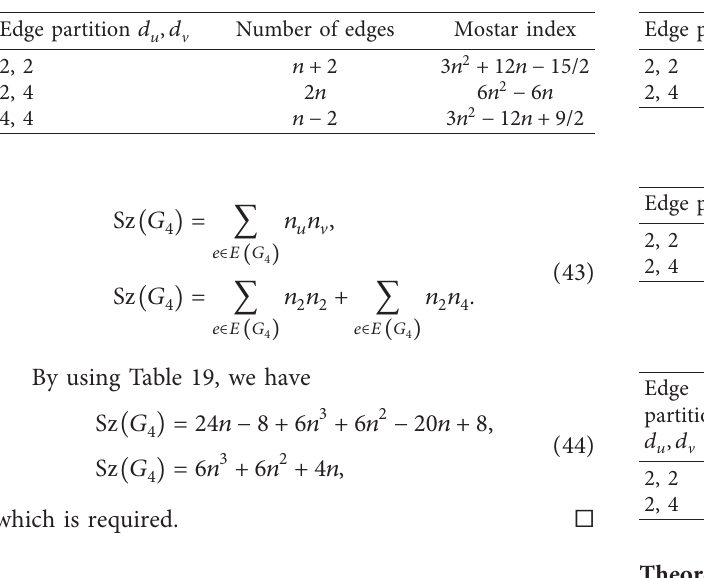
Table 19: Edge partition of para chain of n